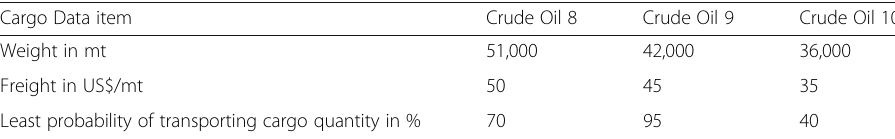
Table 5 Unconfirmed cargo deterministic-equivalent quantity and freight Cargo Data